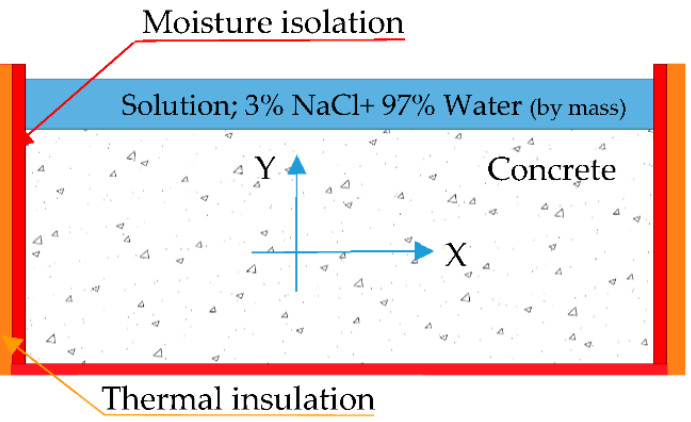
Figure 4. Schematic section of freeze-thaw specimen, electrical resistance measurement’s direction, and amount of solutions on the surface.